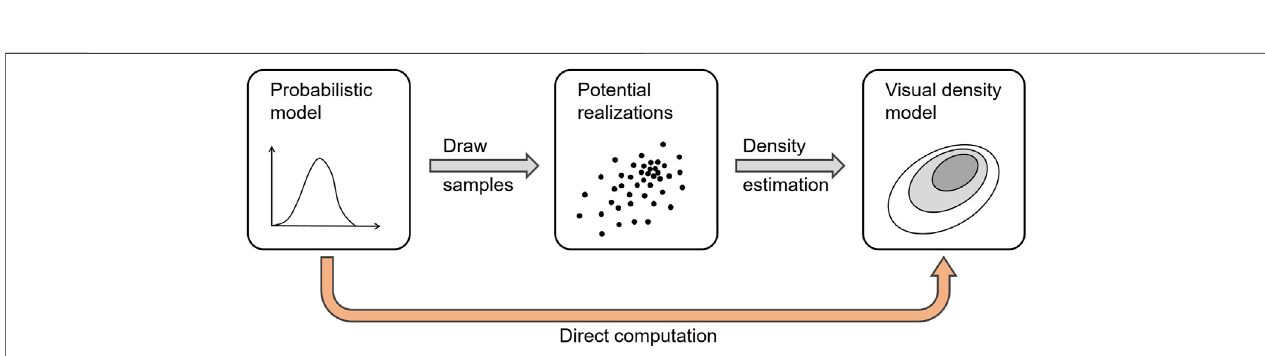
FIGURE 11 | Process of sampling and density estimation for the implicit visualization of distributions.